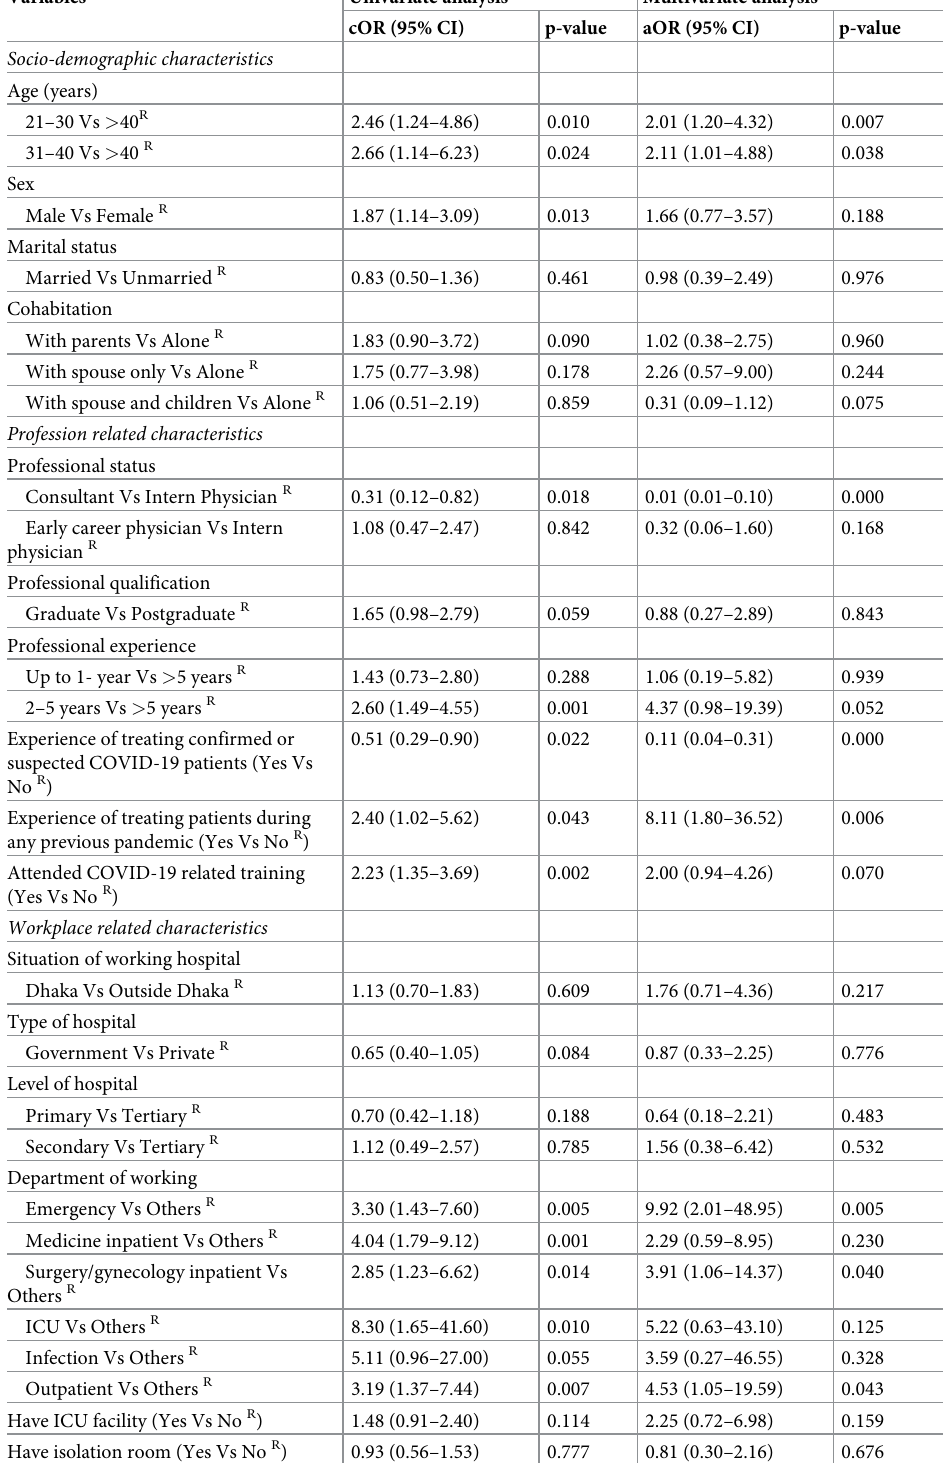
Table 3. Predictors of willingness to work during pandemic (univariable and multivariable logistic